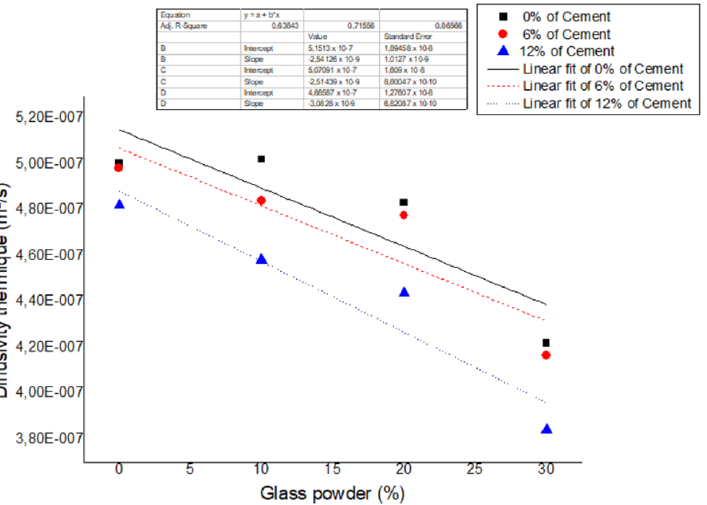
Figure 11. Variation of the thermal diffusivity of the measured mortars in the dry state as a function of the glass powder content.